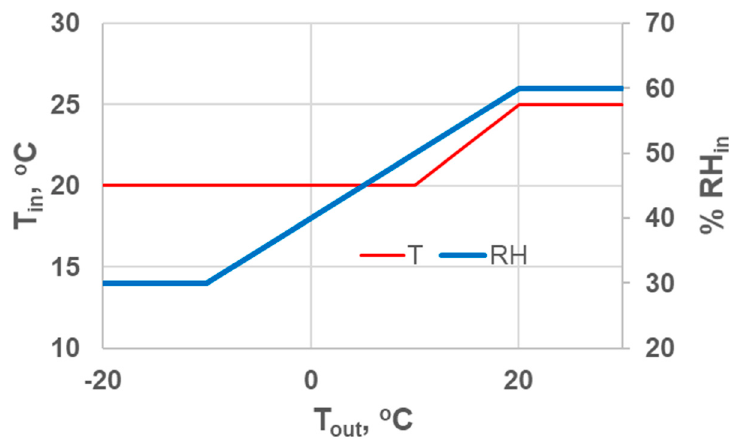
Figure 8. Indoor conditions used in simulations. T in = indoor temperature T out = outdoor temperature RH = relative humidity.